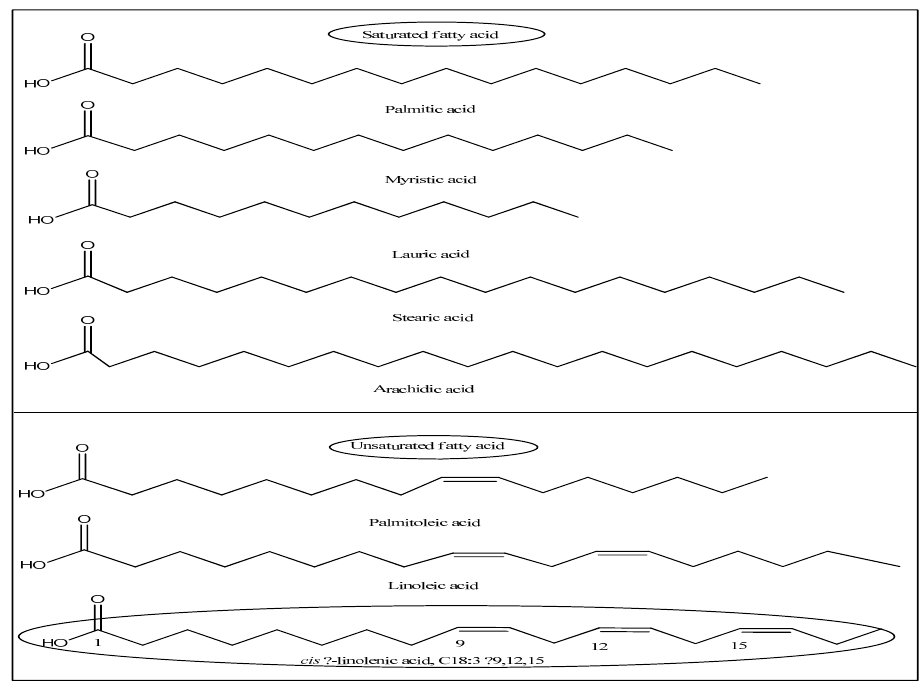
Figure 5. Structures of fatty acids isolated from gorse flower. L weighted AV 0.65 mm, L weighted AV 0.82 mm, where L—Length of an individual fibre.